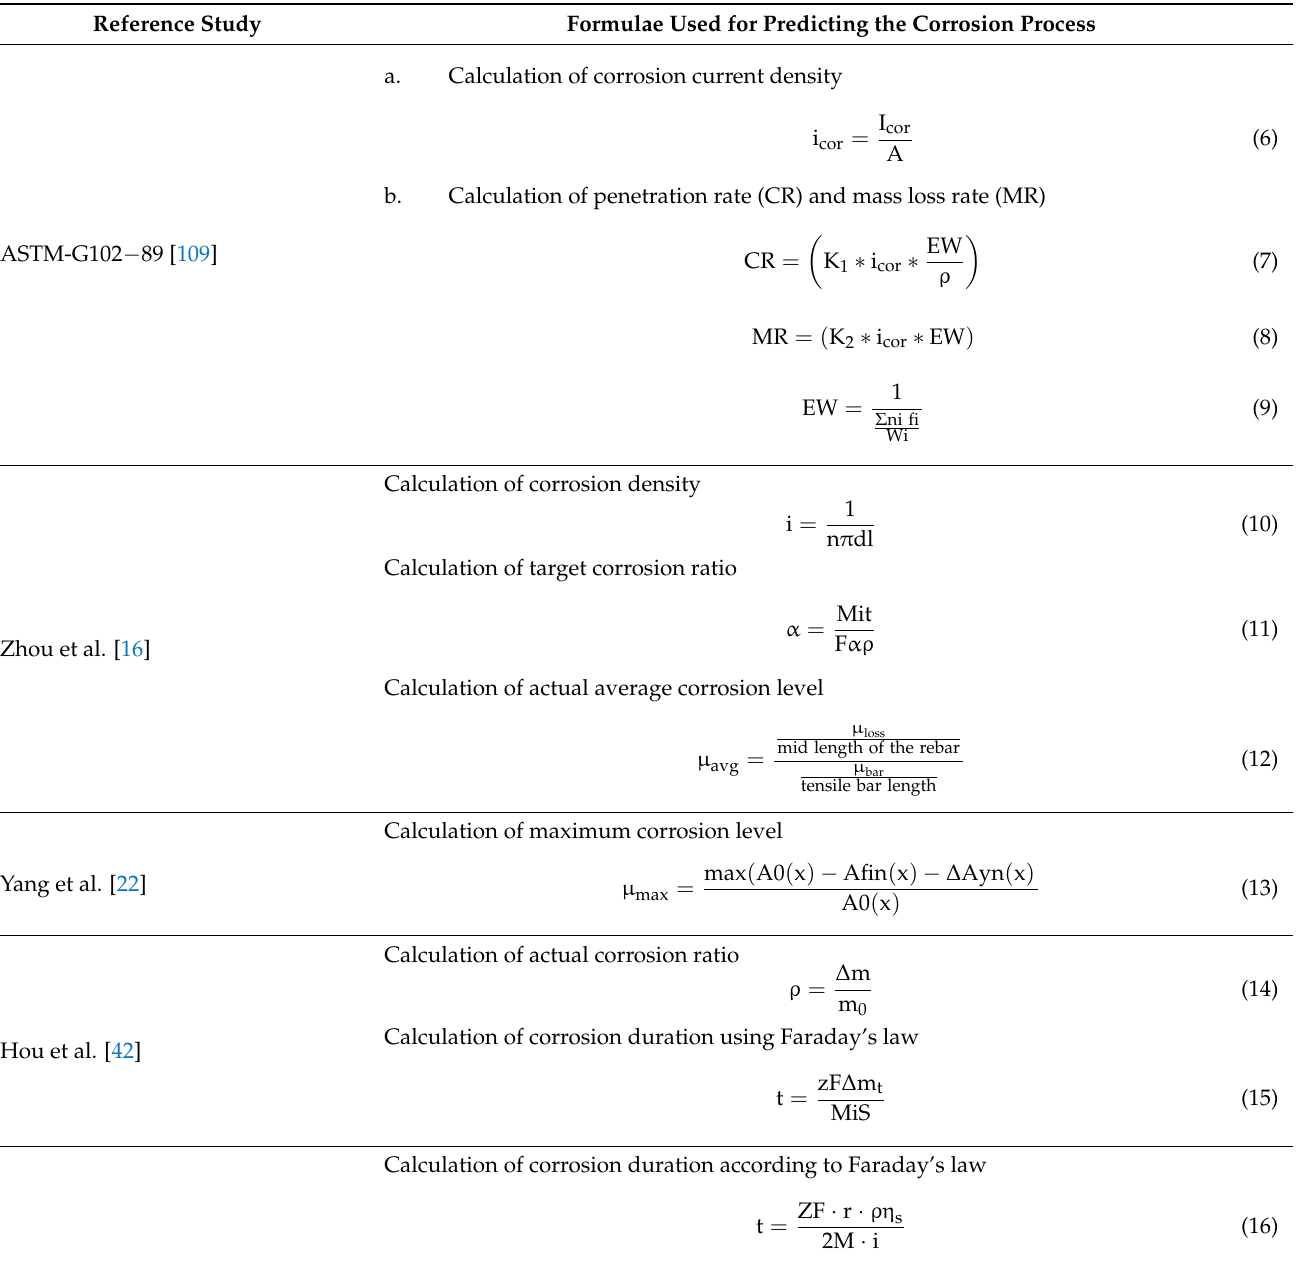
Table 1. Theoretical studies used for predicting mass loss and